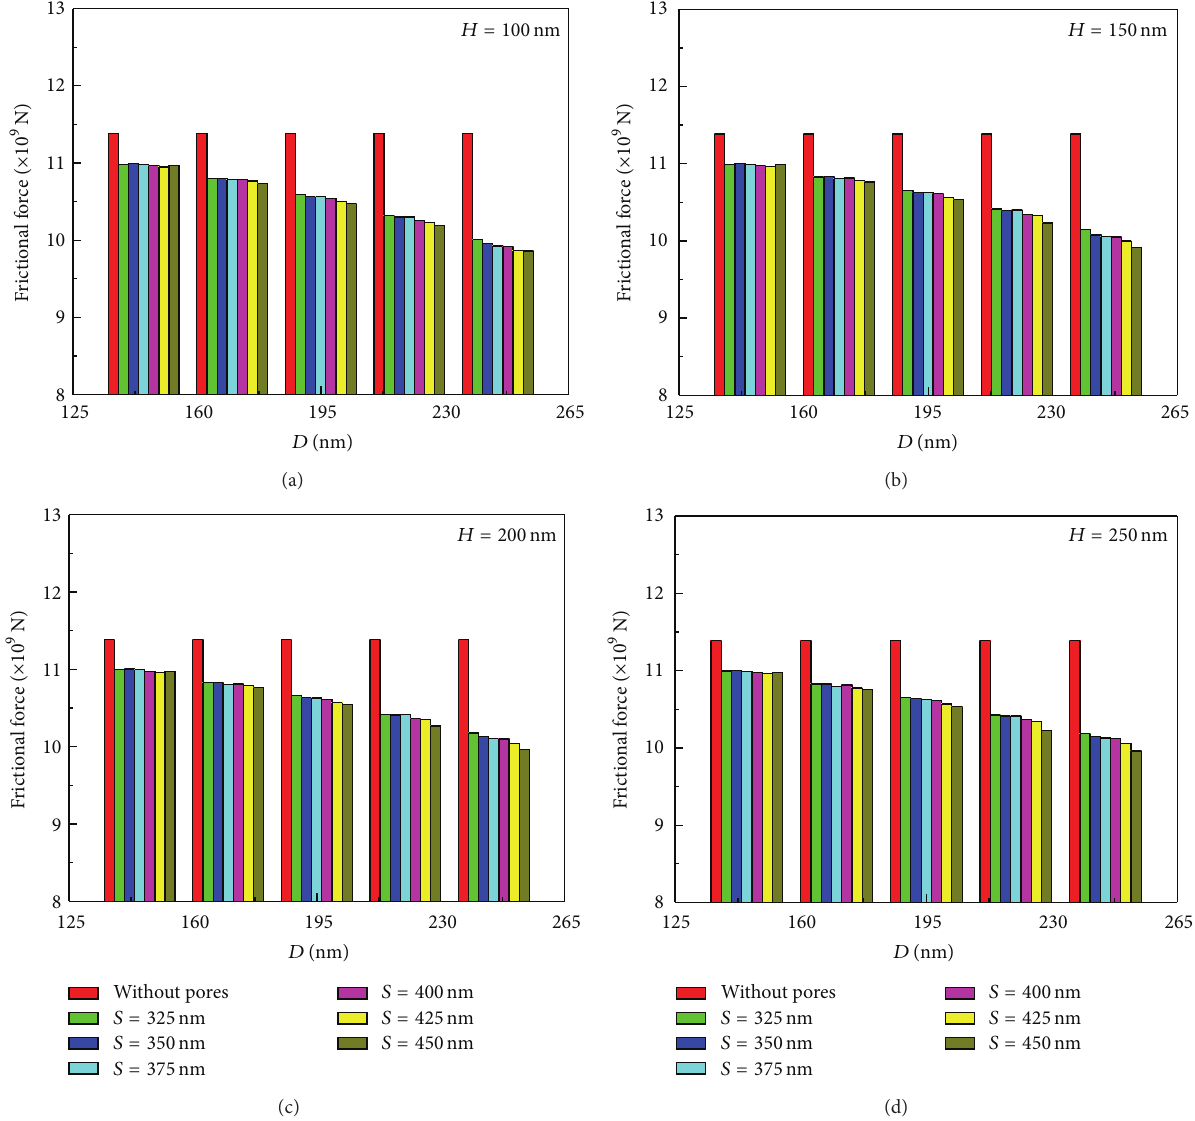
Figure 9: Frictional forces at different intervals of pore: (a) at depth of 100nm, (b) at depth of 150 nm, (c) at depth of 200 nm, and (d) at depth of 250